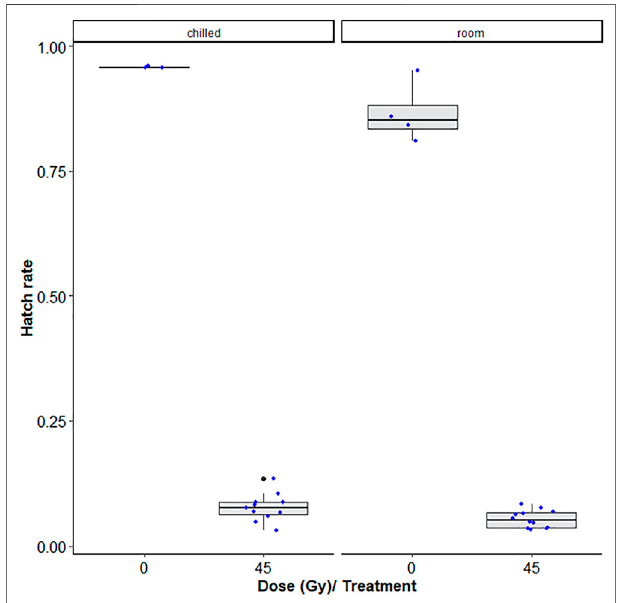
FIGURE 3 | Dose-response shown as egg hatch rate of Aedes aegypti pupae vs. adults. The boxplot shows the median, and upper and lower quartiles. The dots indicate the values obtained for each repetition.